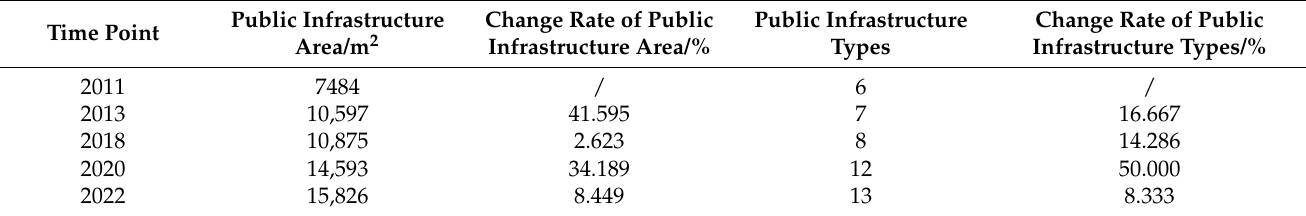
Table 2. The changes in public infrastructure in Lingquan Village at different time